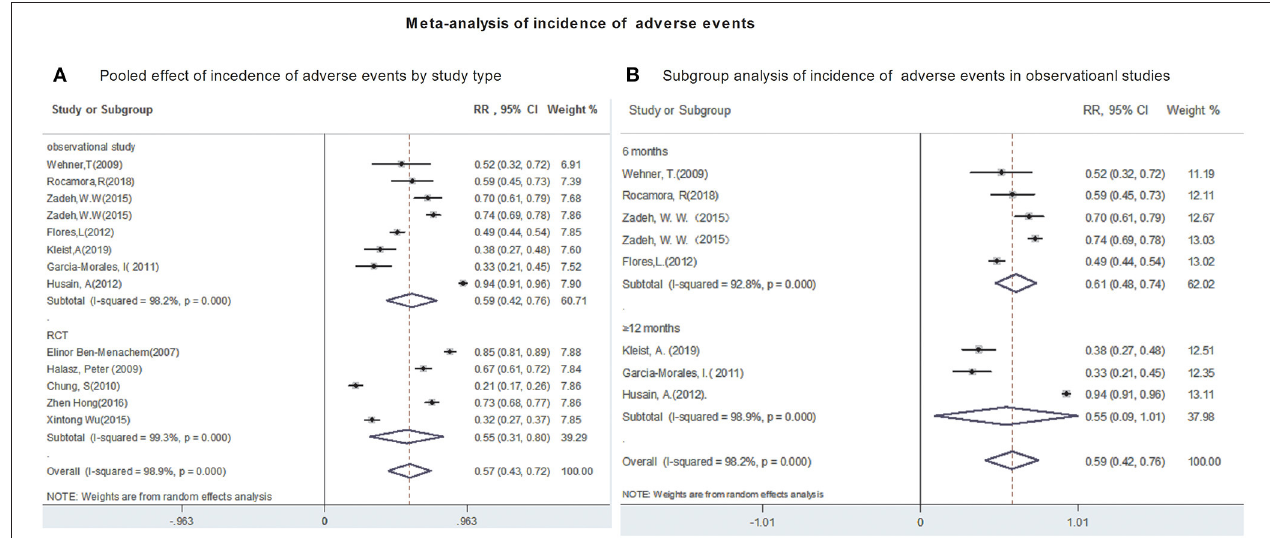
FIGURE 4 | Meta-analysis of incidence of adverse events. (A) Poole effect of incidences of adverse effects by study type. (B) Subgroup analysis of incidences of adverse effects in observational studies.